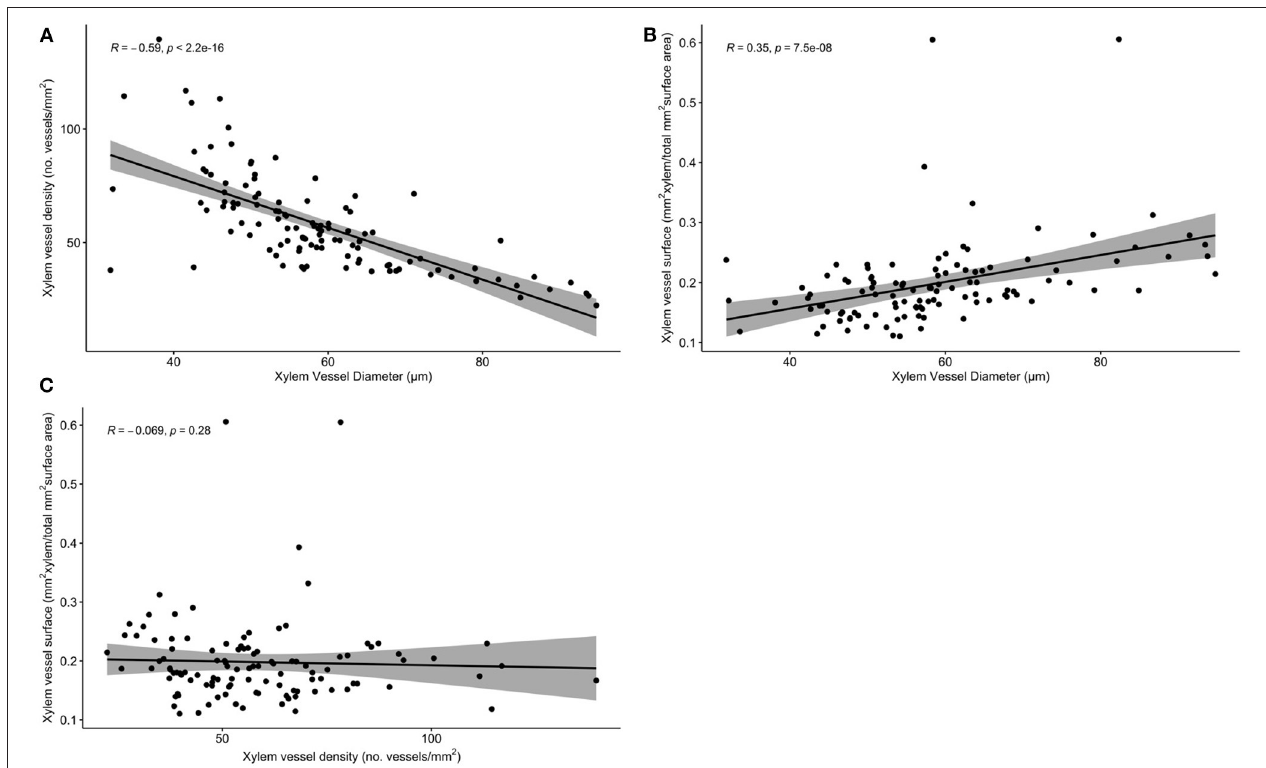
FIGURE 4 | Correlation plots between histological traits using the Kendall rank correlation coefficient. (A) Xylem vessel diameter correlated with xylem vessel density. (B) Xylem vessel diameter correlated with xylem vessel surface area. (C) Xylem vessel density correlated with xylem vessel surface